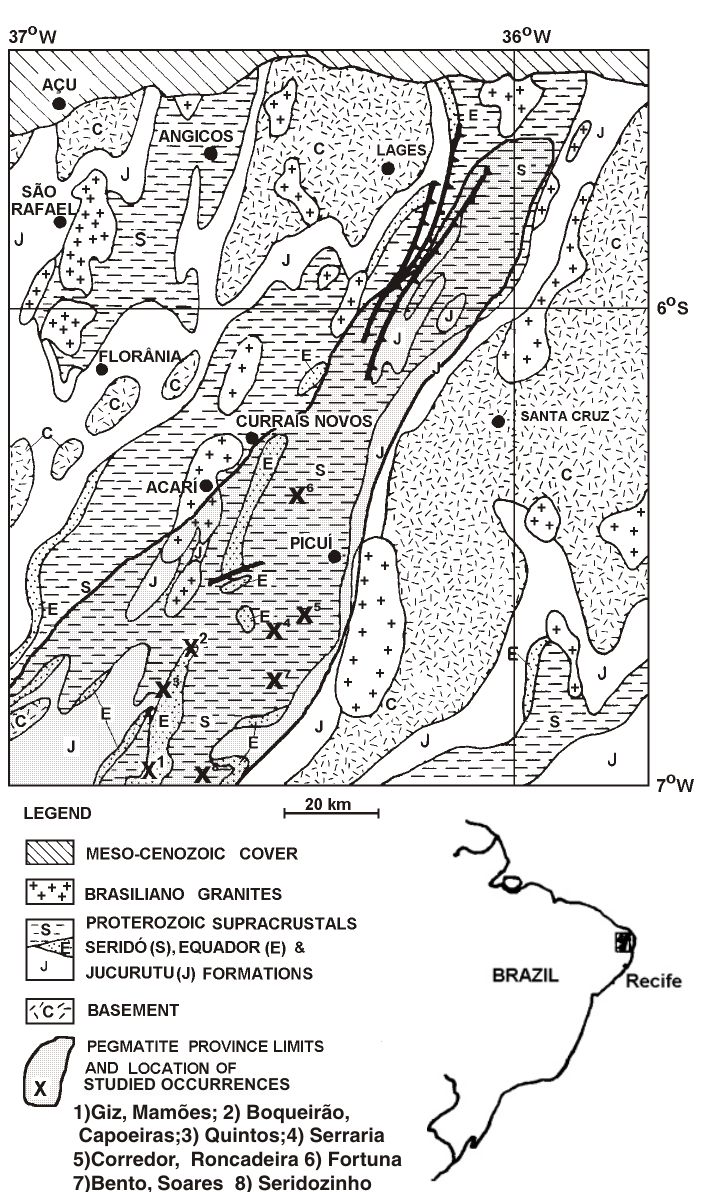
Fig. 1 – Simplified geologic map of the Seridó Foldbelt, modified from Jardim de Sá et al. 1981 and Brito Neves et al. (1995), displaying the extension of the Borborema Pegmatitic Province and the situation of the pegmatites referred to in the